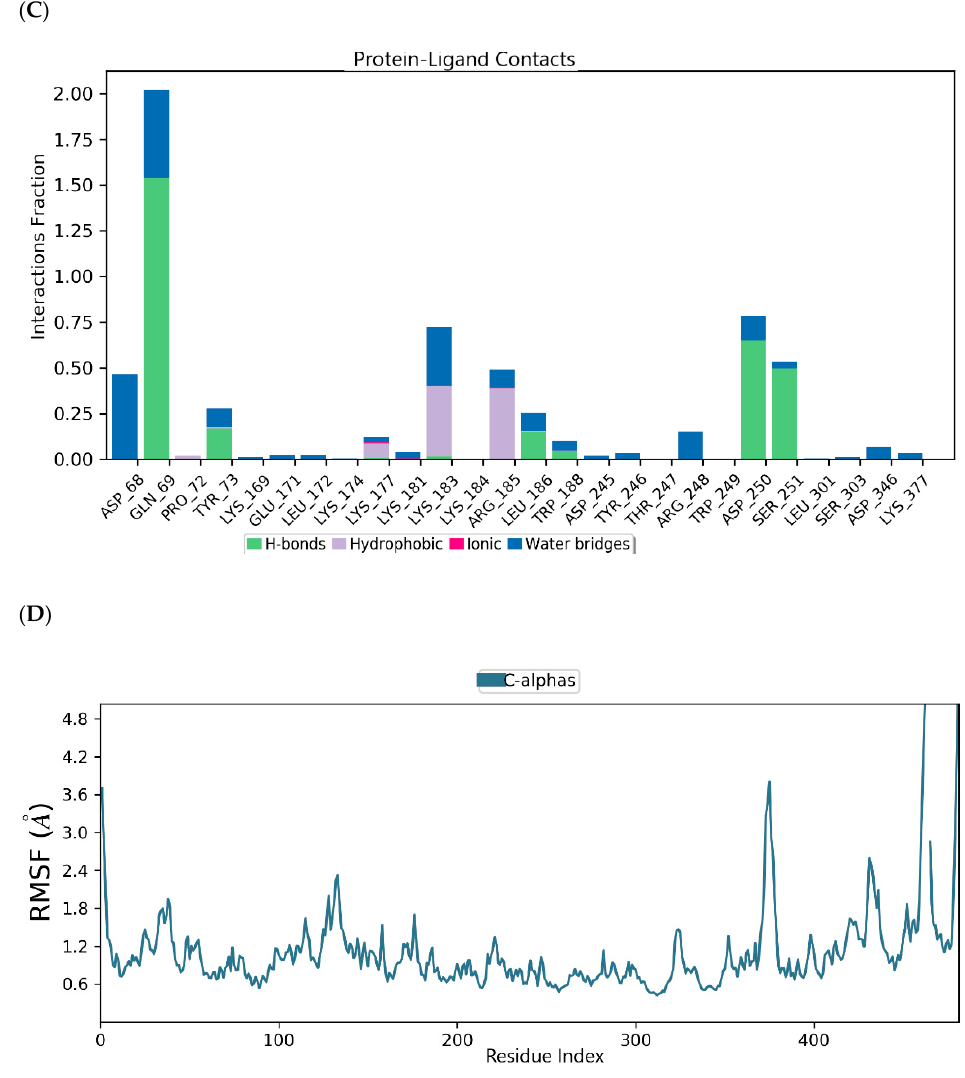
Figure 6. ( A ) MDSs trajectory output revealing the root-mean-square deviation (RMSD) plot of CID-122178506 bound to MNV RdRp; ( B ) Binding interaction of CID-122178506 -MNV RdRp after MDSs; ( C ) Ligplot representing interaction of CID-122178506 with different residues of MNV RdRp throughout the simulation trajectory ( D ) Graphical depiction of root-mean-square fluctuation (RMSF) of CID-122178506 with different residues of MNV RdRp.